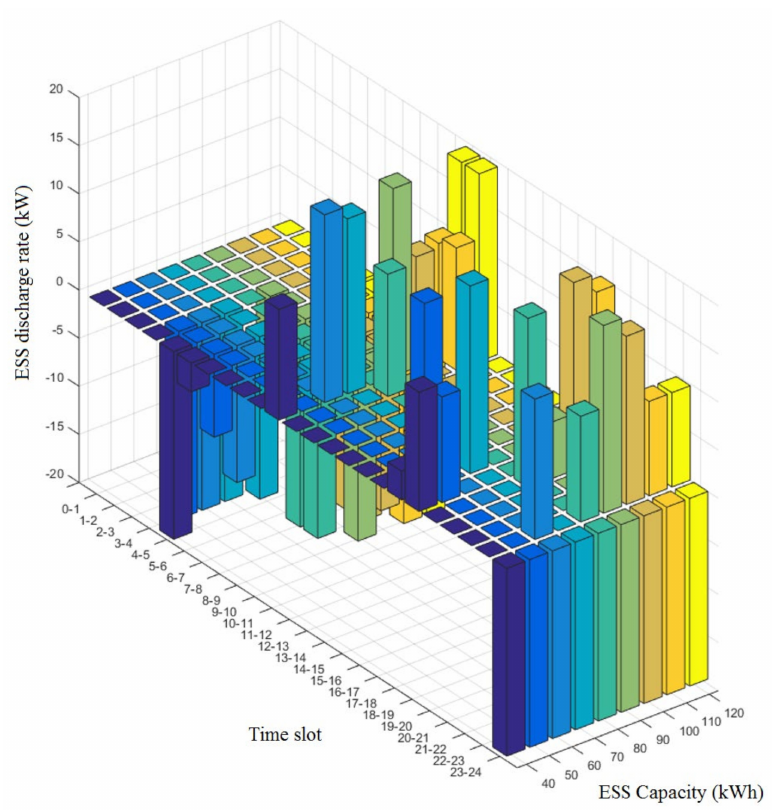
Figure 11. Discharging power by ESS capacity